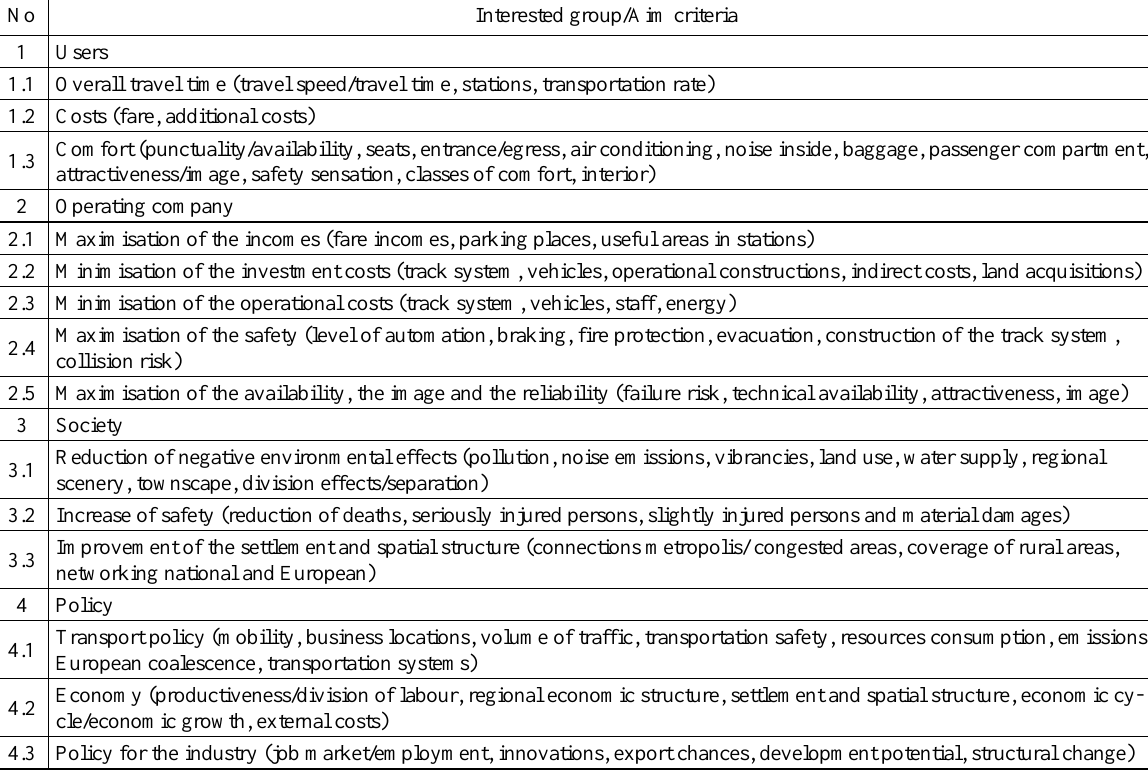
Table 3. System of aim criterions for the multi-dimensional and multi-criteria